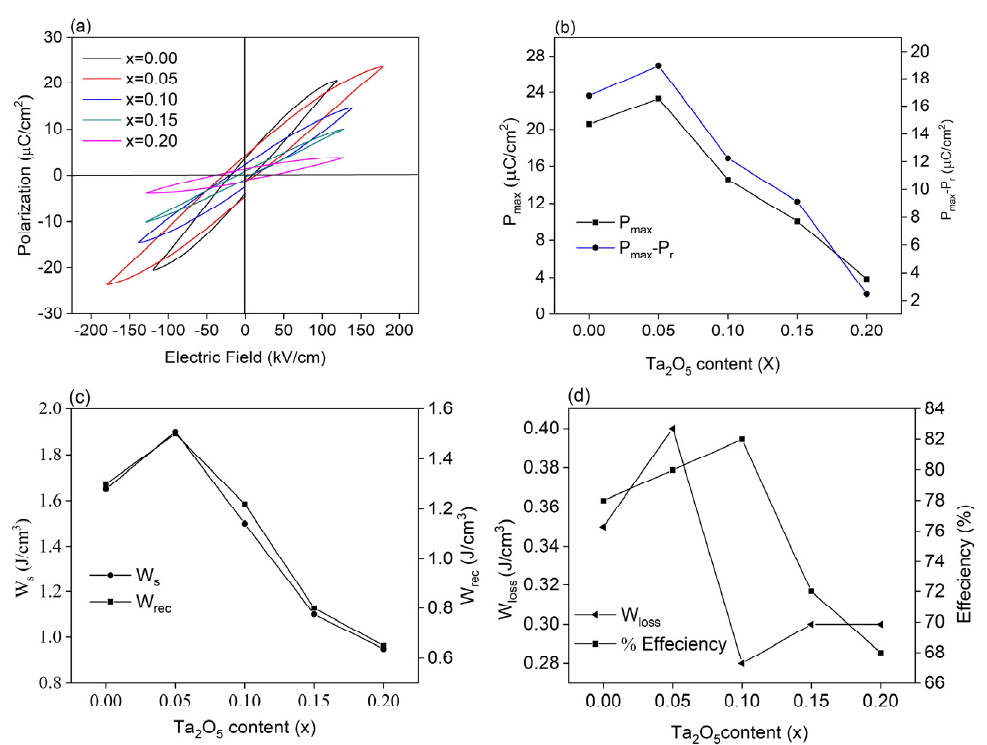
Figure 5. ( a ) Variations of polarization for a series of (NBT-BT-NBN 1 − x T x ) (x = 0.00, 0.05, 0.10, 0.15, 0.20) ceramics composition as a function of the electric field. ( b ) Variations in P max and P max -P r for (NBT-BT-NBN 1 − x T x ) with an increasing x content. ( c ) W s and W rec with an increasing x content. ( d ) Changes in W loss and η for (NBT-BT-NBN 1 − x T x ) with an increasing x content.